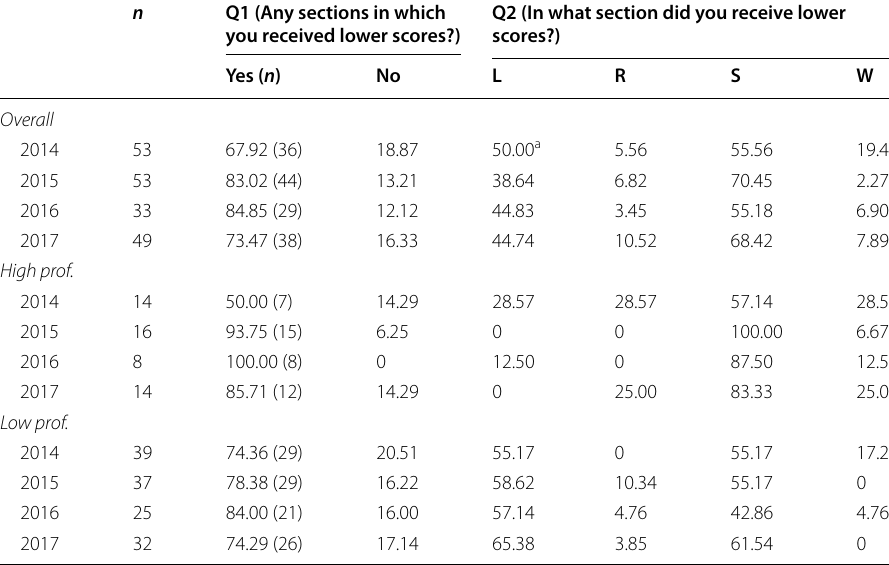
Percentages of participants in the gap group (i.e., those with two- or more-level differences in mastery of skills). High prof. and low prof., higher- and lower-proficiency gap groups. This also applies to Table 10. a 18/36 (the number of those who selected L divided by the number of those who answered “yes” in question 1). Yes and no responses in Q1 do not add up to 100% due to missing responses. In Q2, learners were able to select more than one skill